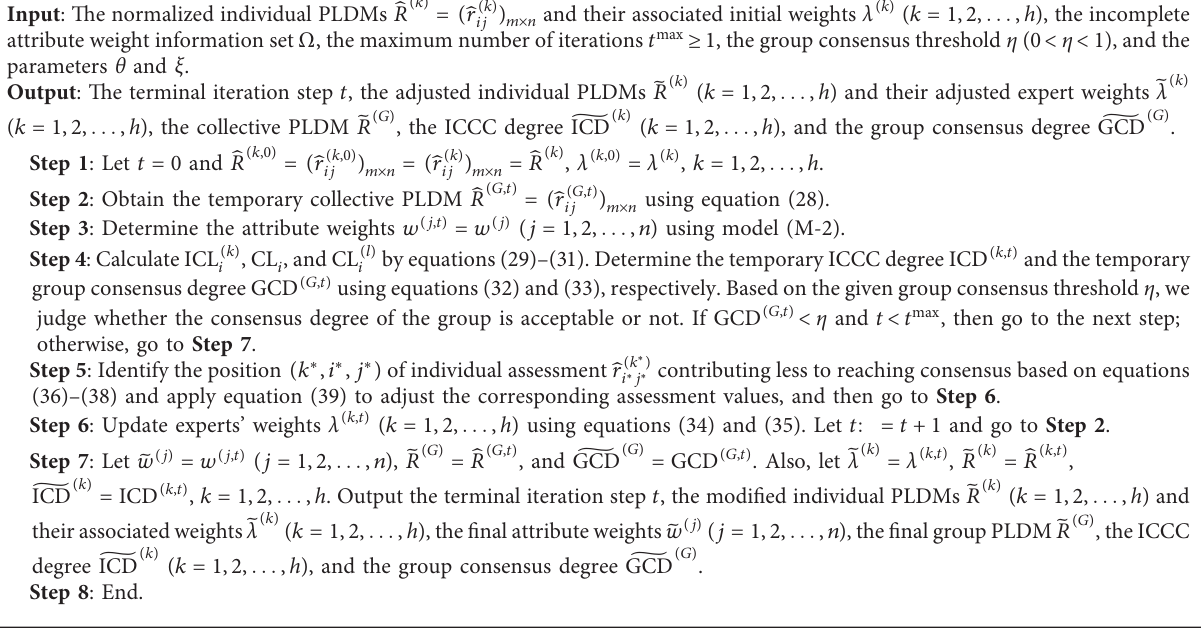
Table 1: The PLDM R ( 1 ) provided by the government departments e